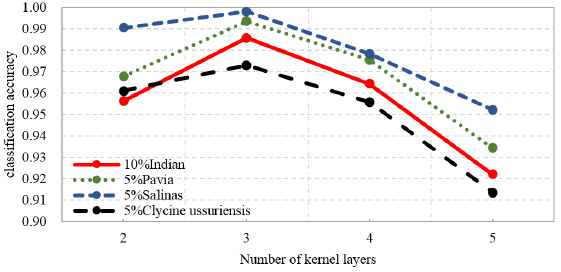
Figure 11. The accuracies obtained with different numbers of kernel layers in